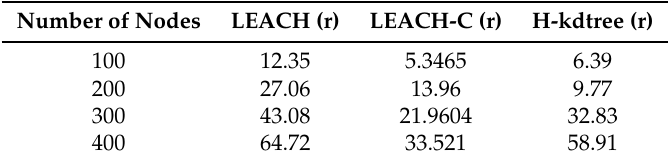
Table 12. Number of death nodes. (r) random.